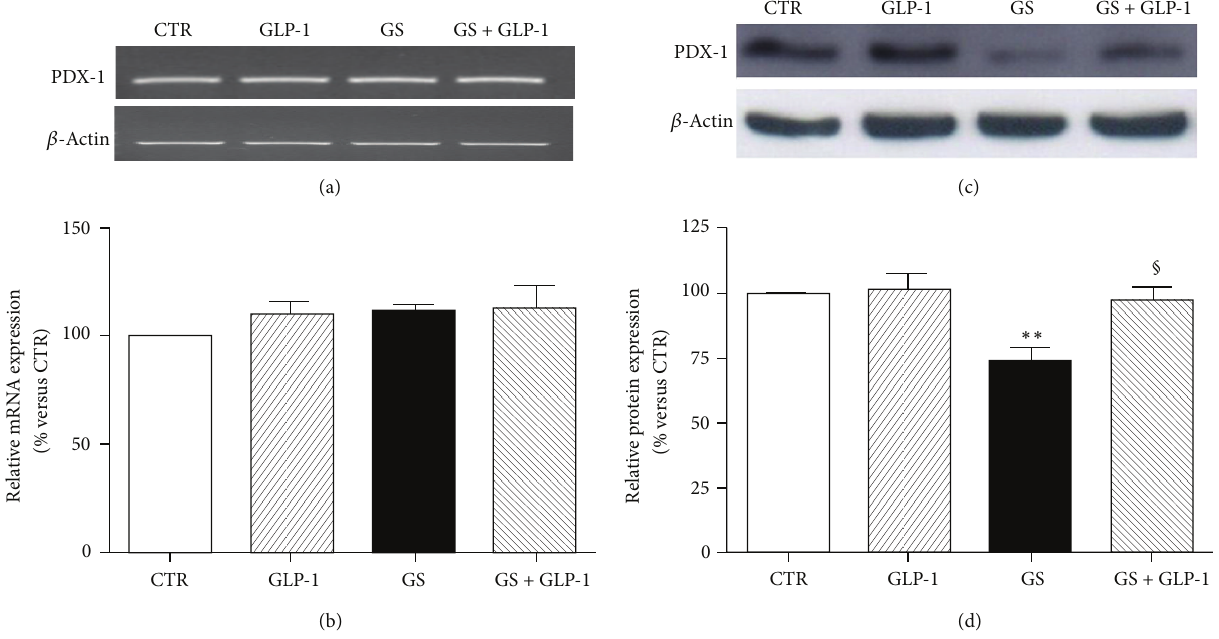
Figure 5: GLP-1 restores PDX-1 protein levels in HIT-T15 cells cultured in the presence or absence of AGEs. (a)-(b) Semiquantitative RT- PCR for PDX-1 mRNA expression in HIT-T15 cells cultured 5 days in standard medium (CTR) or in medium containing AGEs (GS) in the presence or absence of 10nmol/L GLP-1. (a) Representative agarose gel of three different experiments. (b) Quantification of densitometries of agarose gel bands. Data were represented as percentage change from CTR level (100%) ( 𝑛 = 3 ). (c)-(d) Western blot analysis for PDX-1 protein intracellular expression on HIT-T15 cells, cultured in the same conditions of mRNA experiments. (c) Representative western blot of three different experiments. (d) Quantification of densitometries of western blot bands. Data were expressed as mean ± SE of fold induction relative to 𝛽 -actin ( 𝑛 = 3 ). ∗∗ 𝑃 < 0.01 versus CTR; § 𝑃 < 0.05 versus GS.